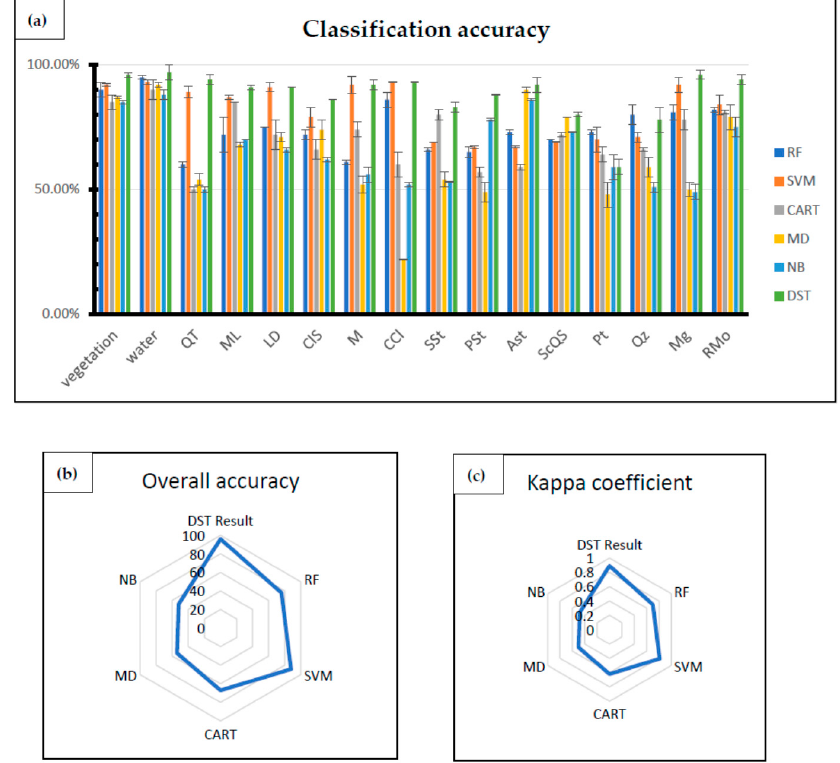
Figure 7. ( a ) The average classification accuracies standard deviation of each class; ( b ) overall accuracies; ( c ) Kappa coefficient using several machine learning algorithms and DST result.